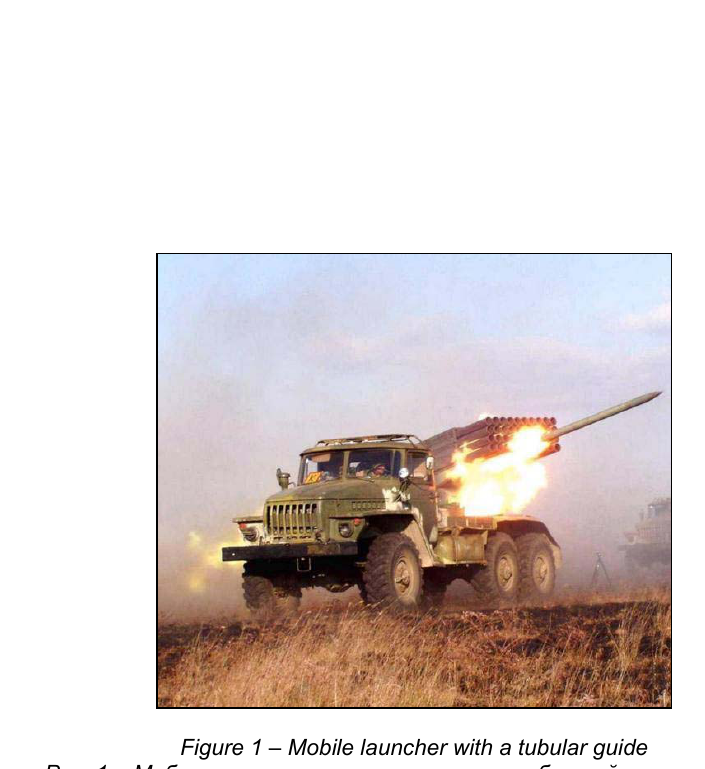
Figure 1 – Mobile launcher with a tubular guide Рис . 1 – Мобильная пусковая установка с трубчатой направляющей Слика 1 – Самоходни вишецевни ракетни